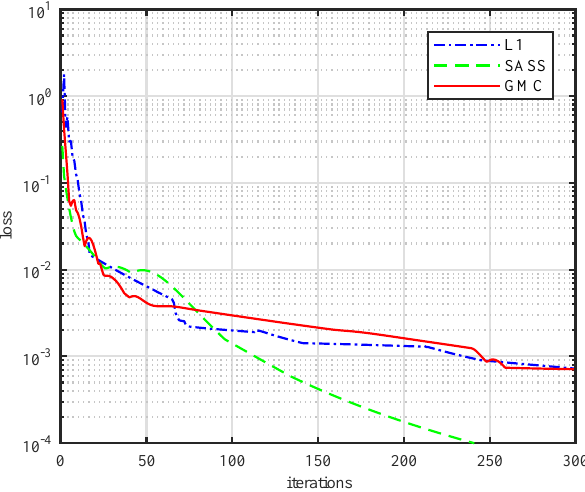
Figure 6. The updating rate of the recovered signal versus iterating numbers.